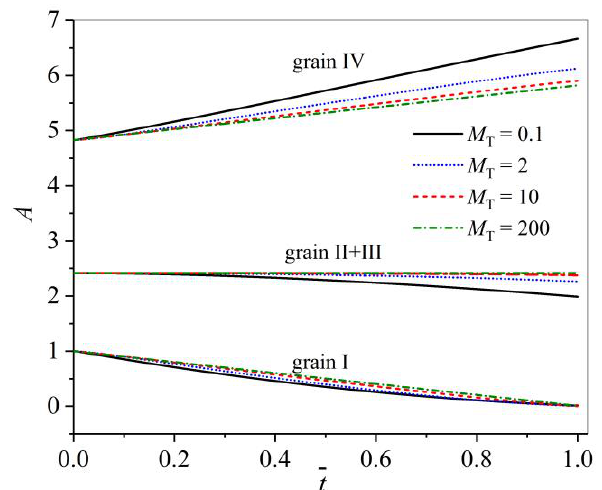
Figure 5. Evolution of the areas 1–4 with respect to time at various values of M T